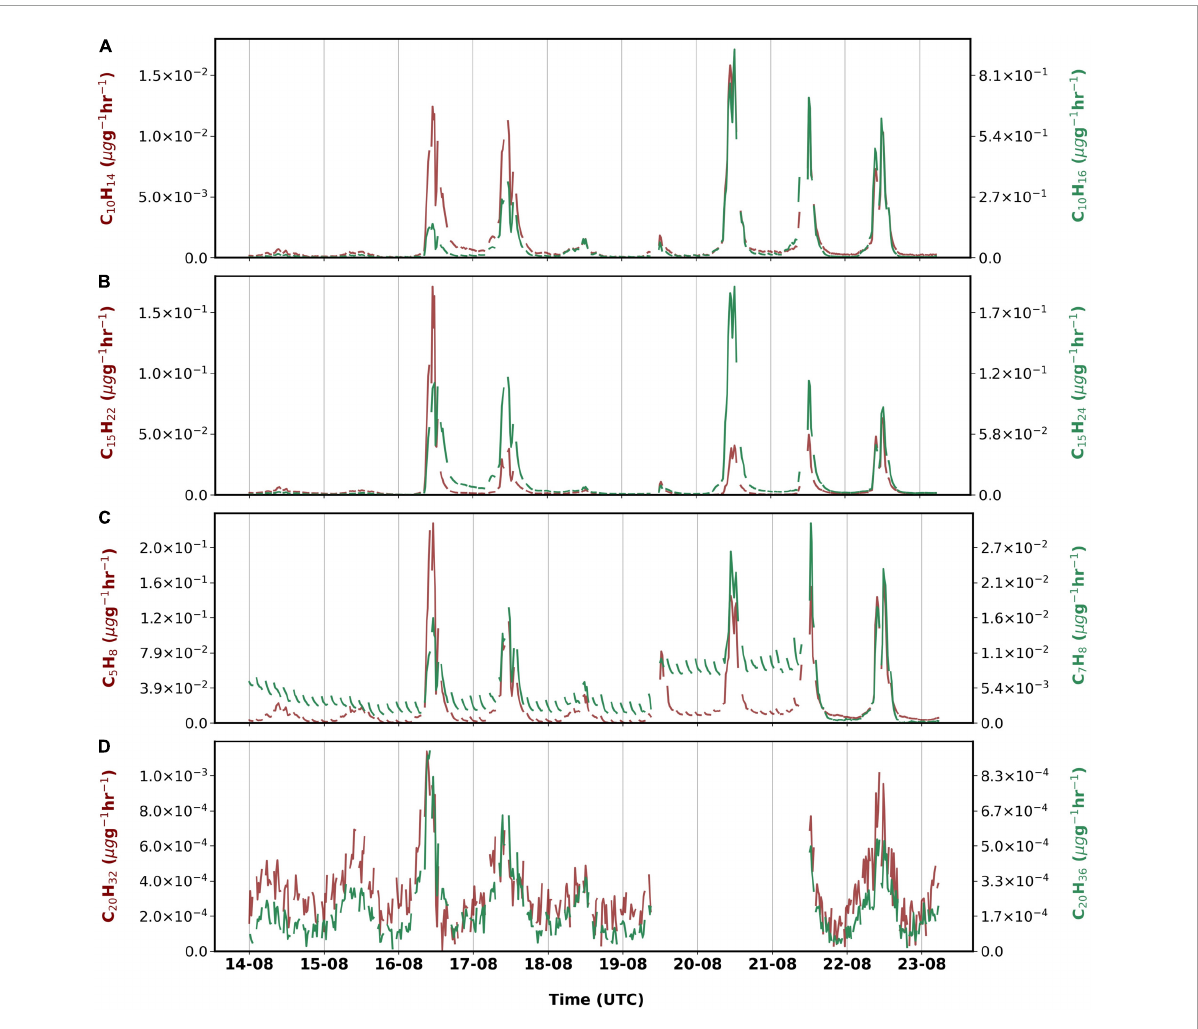
FIGURE4 Emissions rates of (A) monoterpenes, (B) sesquiterpenes, (C) isoprene and toluene and (D) diterpenes measured from 14 August 2019 to 23 August